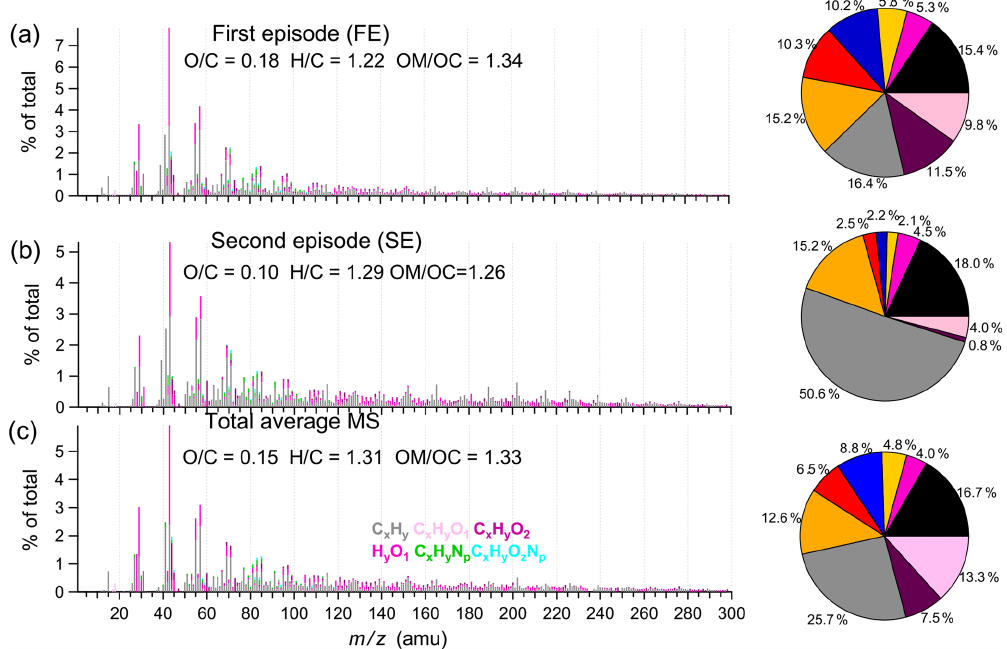
Figure 7. High-resolution mass spectra of the average OA at different episodes: (a) first episode (FE), (b) second episode (SE) and (c) whole campaign (inset pies show the average compositions during corresponding episodes; colors of different components are consistent with those in Fig.